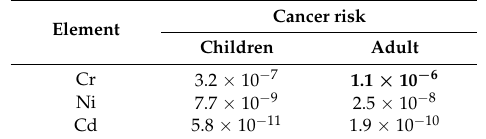
Table 5. Cancer risk values for Cr, Ni and Cd from Santiago